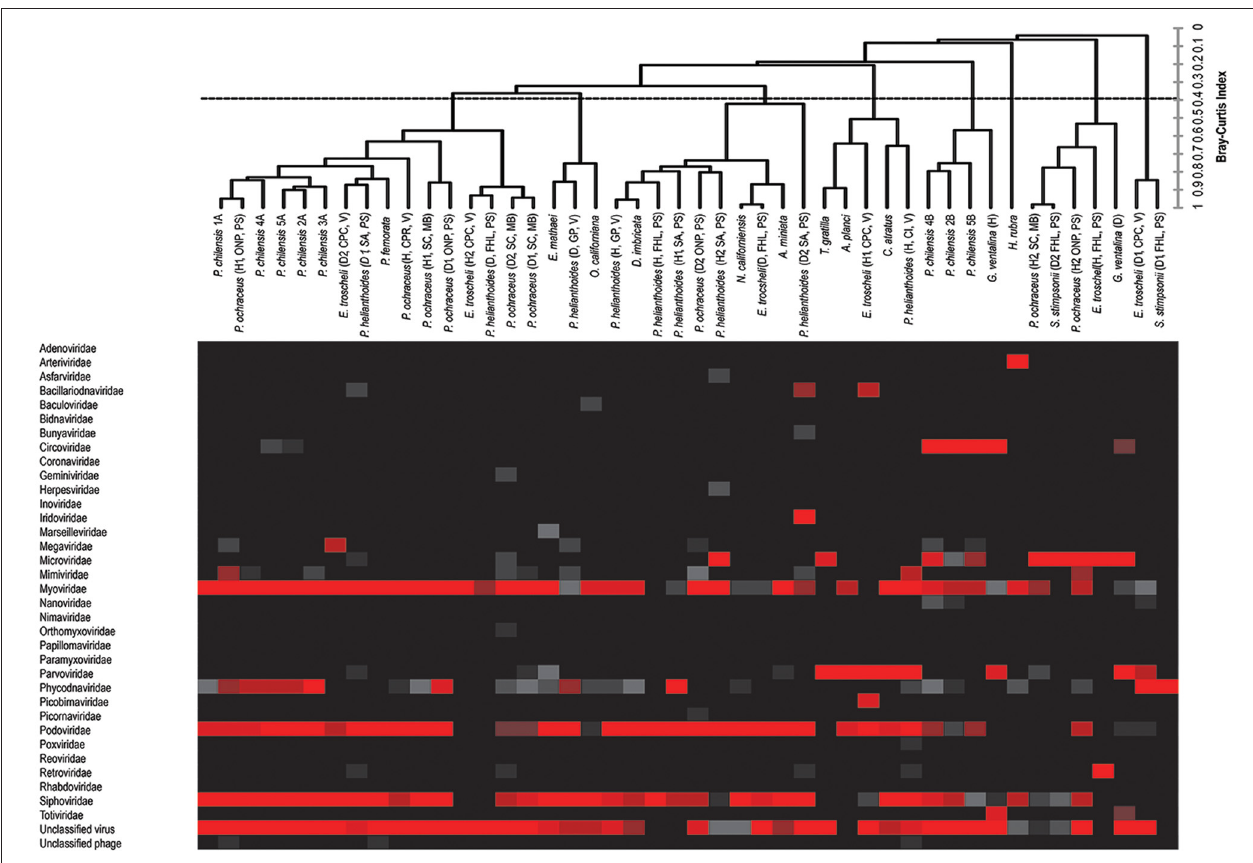
FIGURE 1 | Combined heat map of viral family abundance and agglomerative hierarchical clustering (AHC) dendrogram visualizing relatedness between viral communities of sampled hosts at the viral family level. The dendrogram was created by unweighted-pair-group-mean average (UPGMA) and was based on the Bray–Curtis Similarity Index, and includes bacteriophage (see Figure 2 for patterns of clustering in the absence of